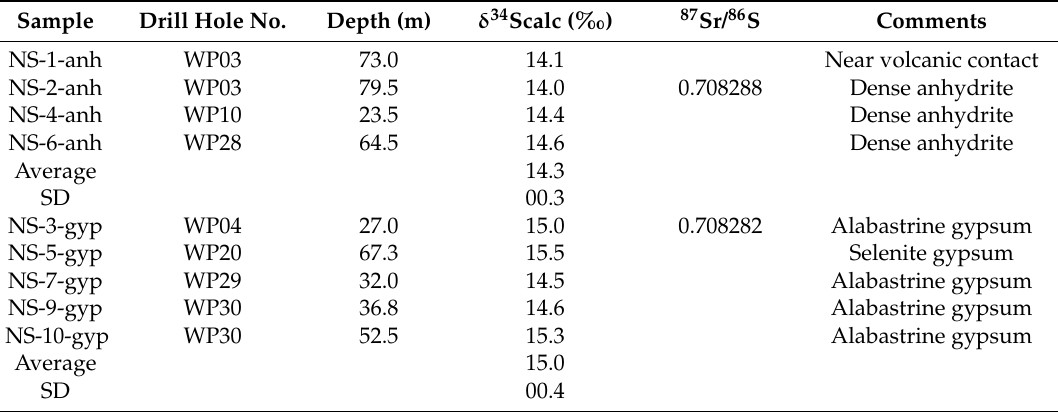
Table 1. Stable sulfur and strontium isotope ratios of the gypsum–anhydrite beds in the exploration wells, Wang Saphung area, Loei Province,